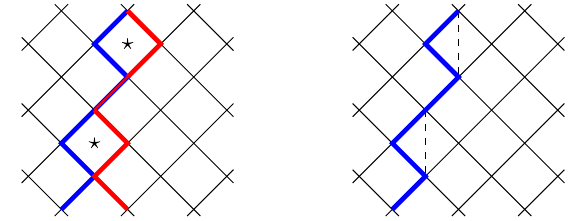
FIG. 6. Domain walls on a tilted square lattice. Left: In the replica approach, two domain walls have an attractive interaction when they both visit two sides of a plaquette (starred). Right: This replica treatment describes a single domain wall subject to a random potential on the vertical bonds. The domain wall in the figure is affected by the potentials on the two dashed